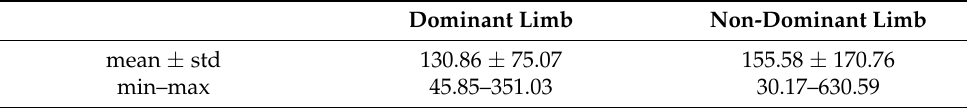
Table 10. Data obtained for the Upper Body Index indicator in the stroke patient